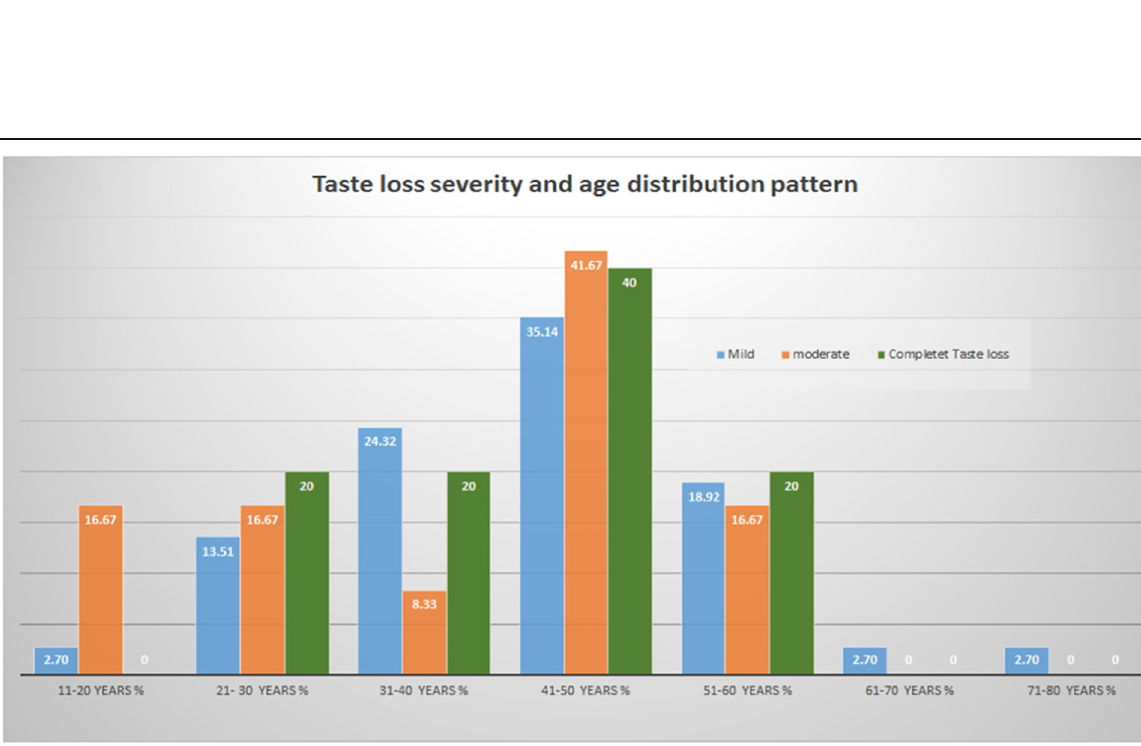
Fig. 3 The percentage of taste loss severity in the different age